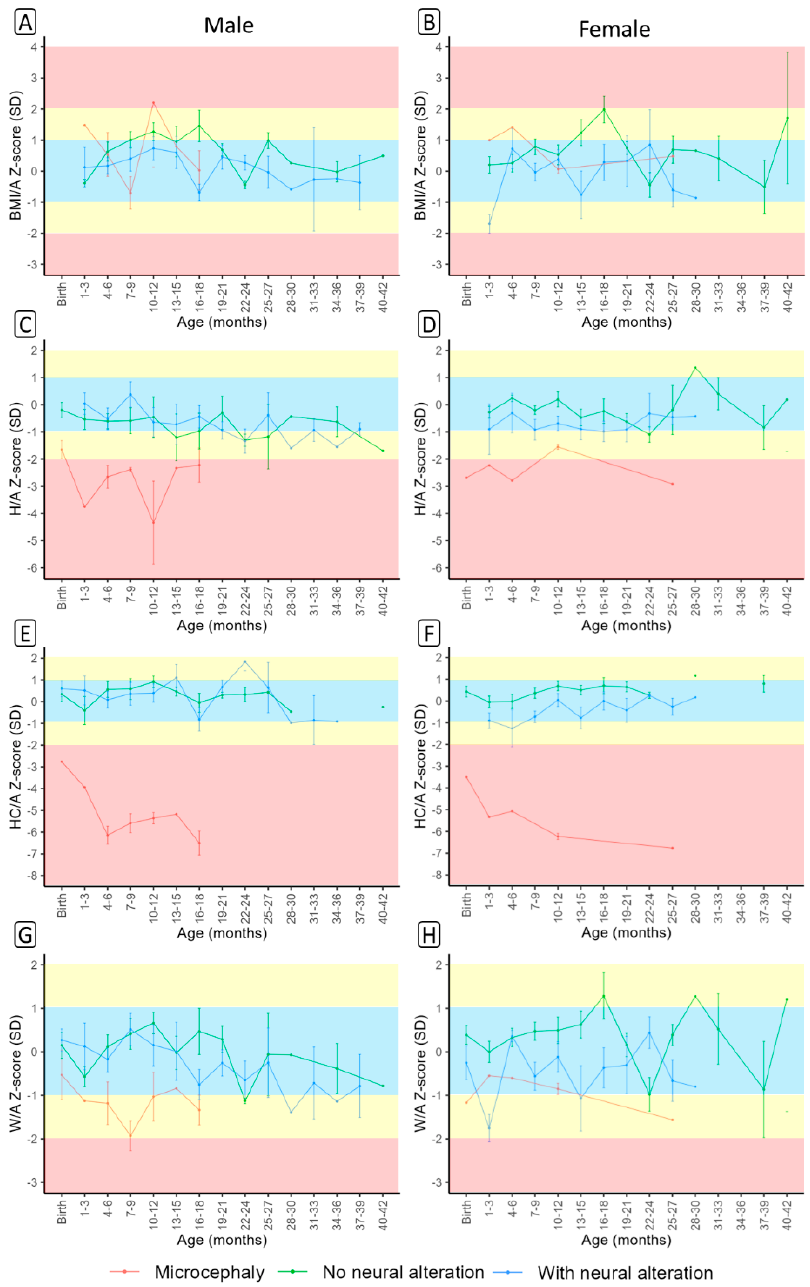
Figure 1. Body mass index (BMI/A) ( A , B ), height (H/A) ( C , D ), head circumference (HC/A) ( E , F ) and weight (W/A) ( G , H ) z-scores by sex between non-microcephalic (with and without neurological alteration) and microcephalic children according to age.